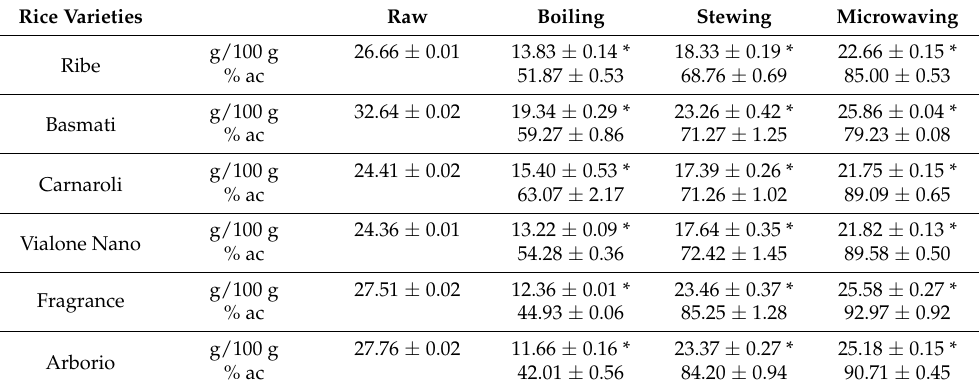
Table 5. Amylose content (g/100 g) of both raw and cooked rice and percentage of retained amylose after the three cooking methods